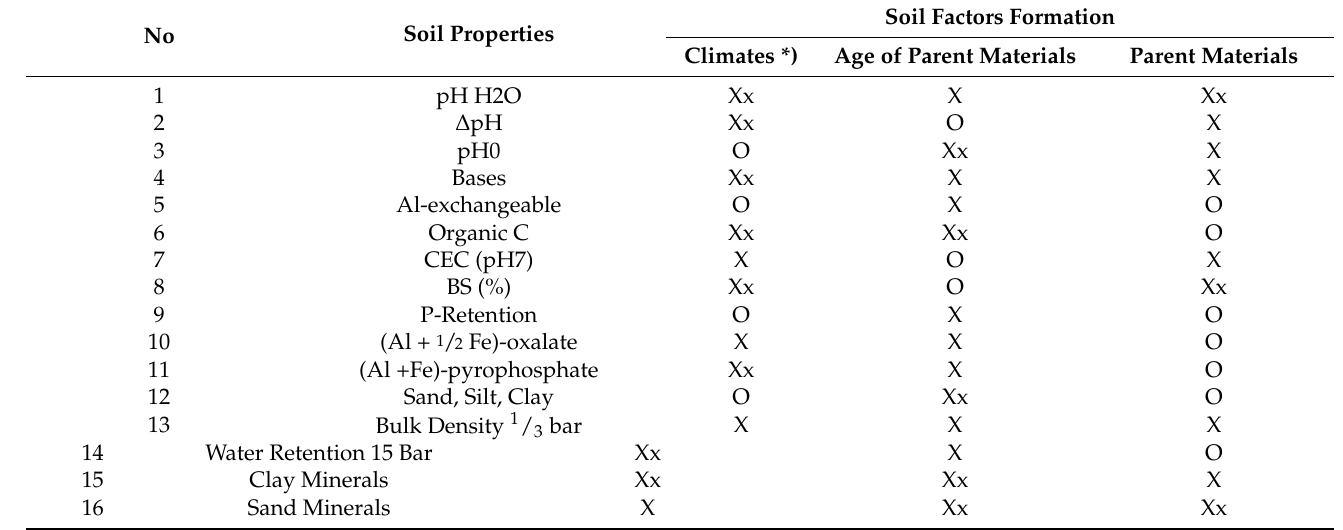
Table 7. The Relationship of Soil Forming Factors with Some Chemical, Physical, and Mineralogical Characteristics of